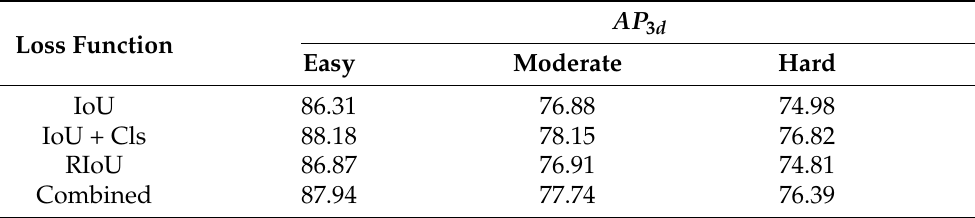
Table 5. AP 3 d with four loss function strategies on the validation